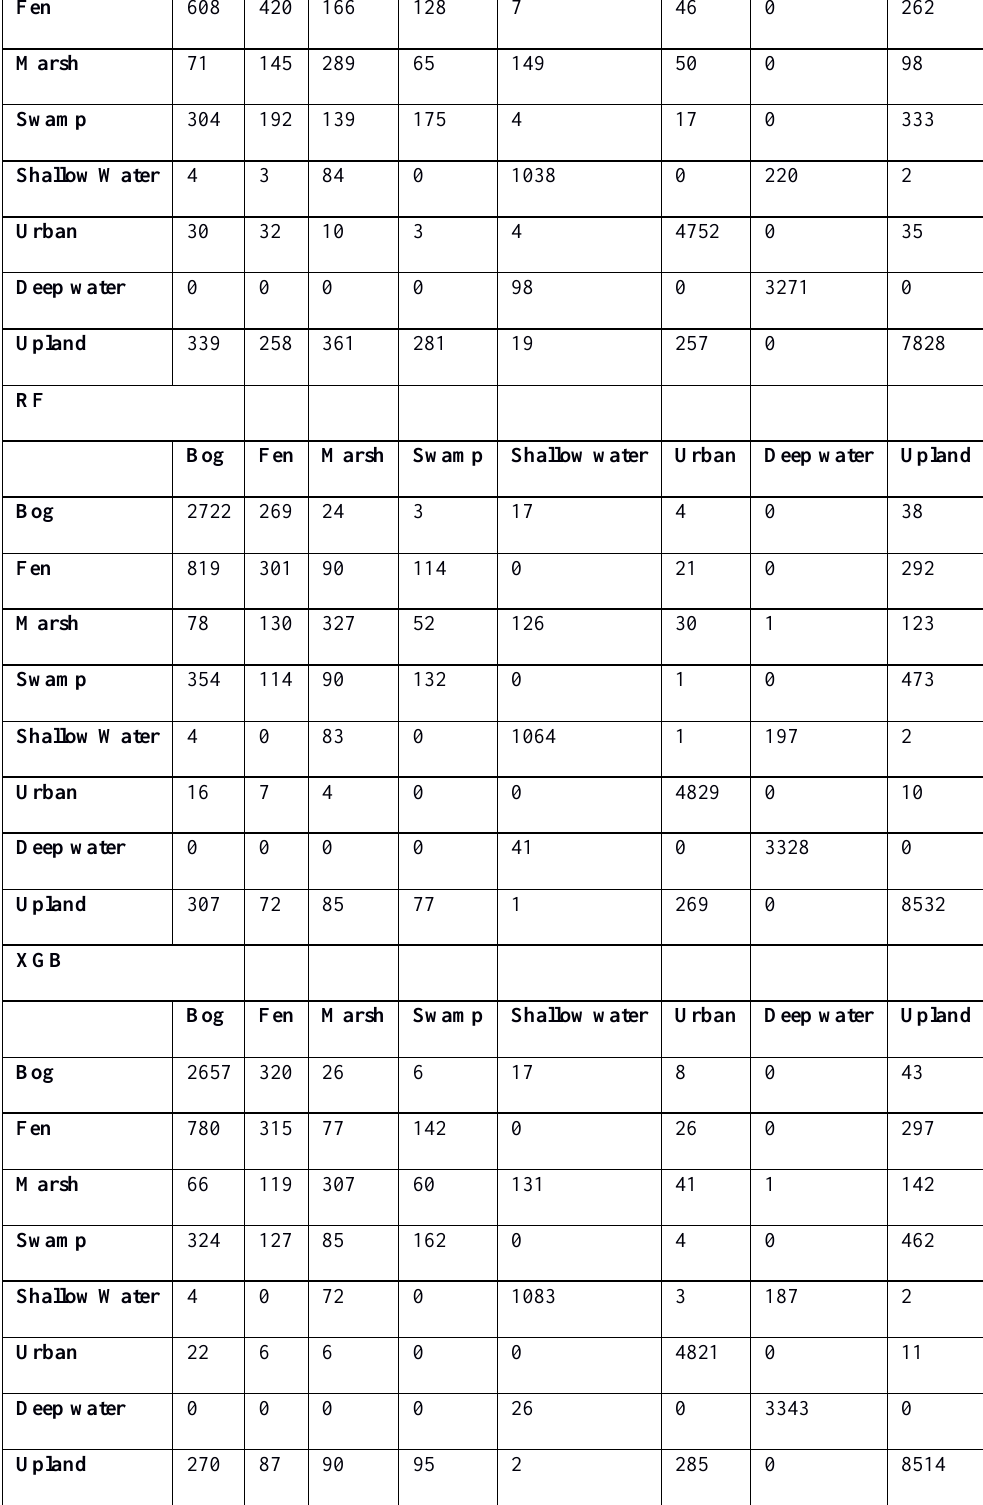
Table 4 . Confusion matrices of the wetland classification using the Decision Tree (DT), Random Forest (RF), and Extreme Gradient Boosting (XGB) in Google Earth Engine.